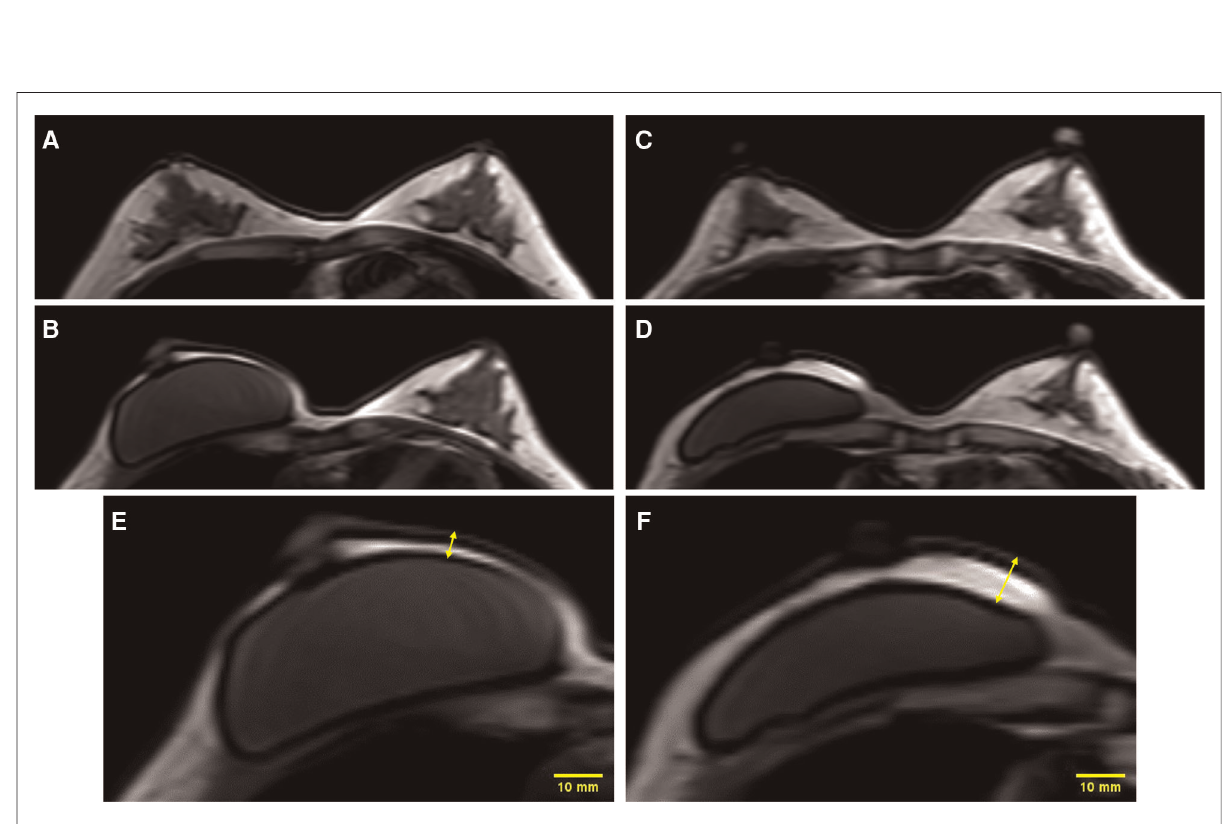
FIGURE 3 Difference in mastectomy fl ap thickness between c-NSM and m-NSM on MRI images: ( A ) preoperative MRI image of the patient with right breast cancer; ( B ) one-month postoperative MRI image of the same patient after c-NSM and IBR using implant; ( C ) preoperative MRI image of another patient with right breast cancer; ( D ) postoperative MRI image after m-NSM and IBR using implant at 1-month follow-up; ( E ) 2x image of the breast shows the fl ap thickness of 4.92 mm after c-NSM; ( F ) fl ap thickness was 10.23 mm after m-NSM. c-NSM, conventional Nipple Sparing Mastectomy; m-NSM, modi fi ed Nipple Sparing